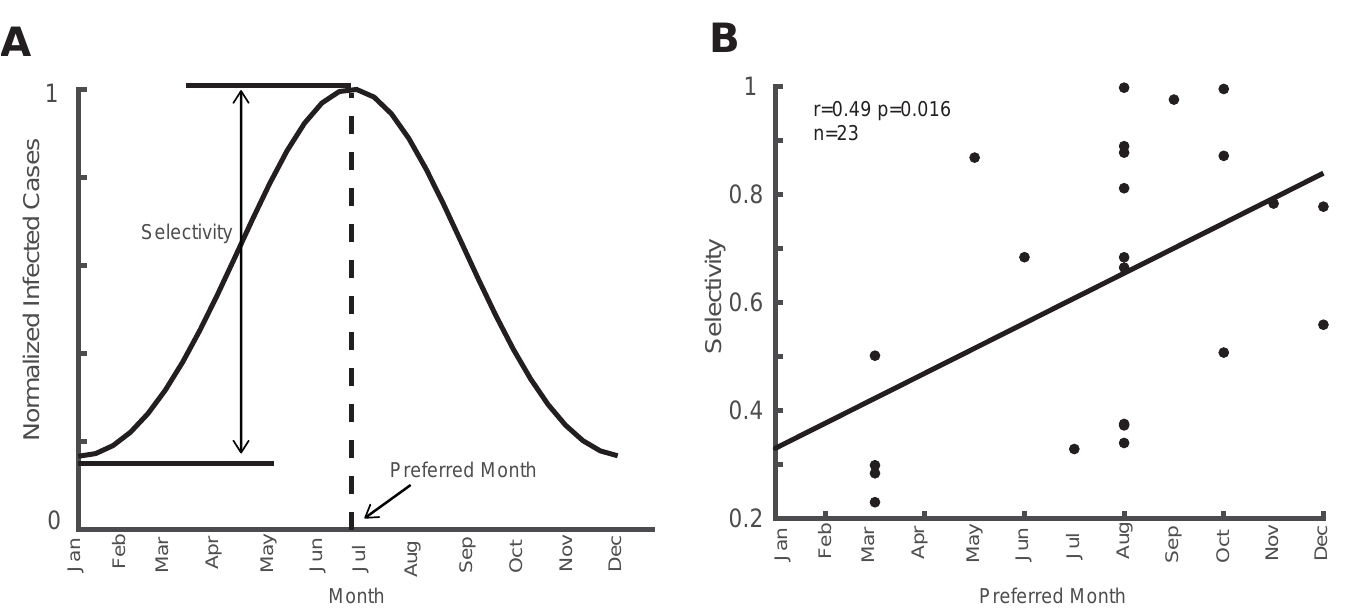
Fig 2. Relationship between the preferred month and the selectivity index. Plot A demonstrates preferred month and selectivity. The scatter plot in B shows the relationship between the preferred month and the selectivity index of 23 infectious diseases.